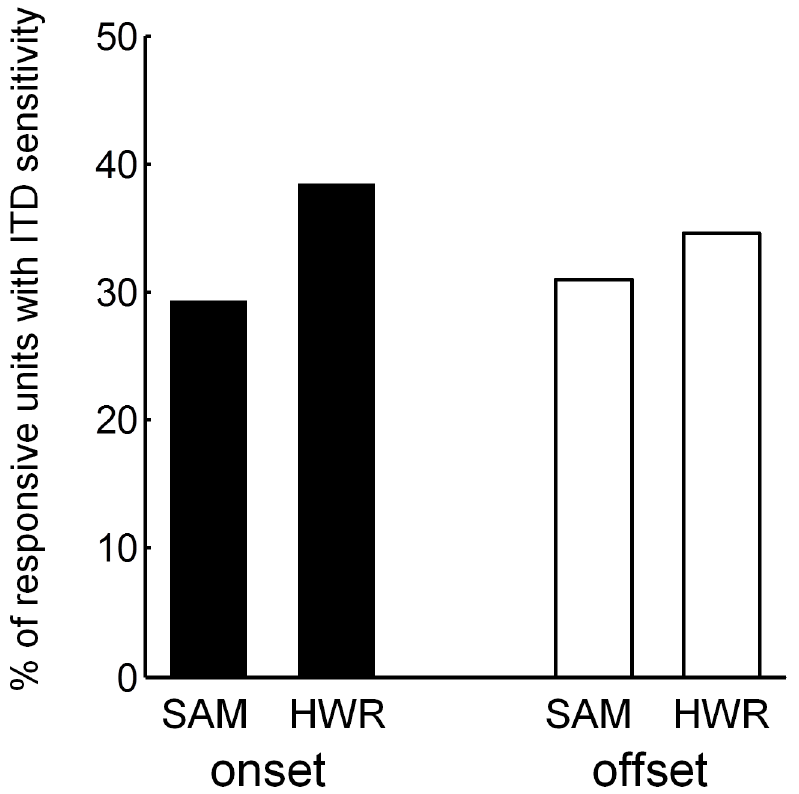
Figure 8. ITD sensitive units in normal-hearing animals. Percentage of responsive units with ITD sensitivity within the onset and offset response to SAM and HWR tones.